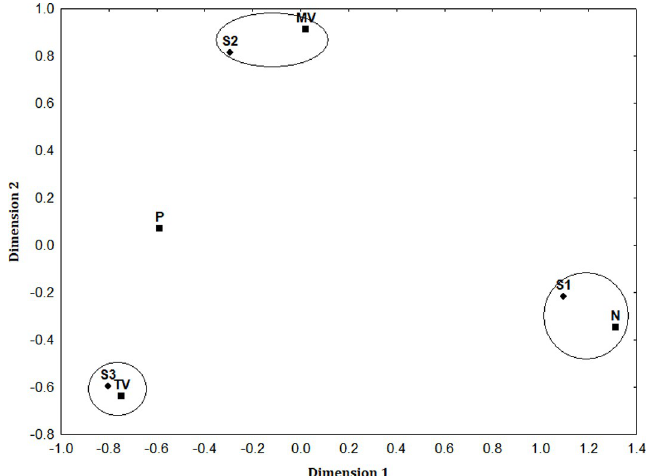
Fig 5. Relationships between disturbance sources and mother-pup reaction scenarios, according to multidimensional scaling. Scenario 1 (S1)–although nursing is momentarily interrupted by a disturbance, the mother-pup pair does not flush and continues to nurse; Scenario 2 (S2)–nursing is interrupted by a disturbance and the pair flushes, but recovers in less than 10 min and continues to nurse; and, Scenario 3 (S3)–nursing is interrupted by a disturbance, the pair flushes, and nursing does not resume until the end of the low tide cycle occurring during the sampling effort conducted on that day. The control observations (C) comprised nursing events that were not interrupted because no disturbance source was present.Disturbance sources: P = pedestrians; MV = motorized vehicles; N = noise; and, TV = terrestrial